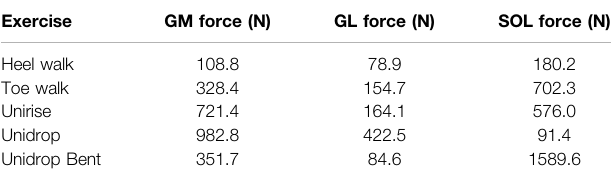
TABLE 1 | The estimated peak muscle forces during the rehabilitation exercises, applied on each sub-tendon and used as boundary conditions for the fi nite element analysis. The unit of the muscle forces is Newton